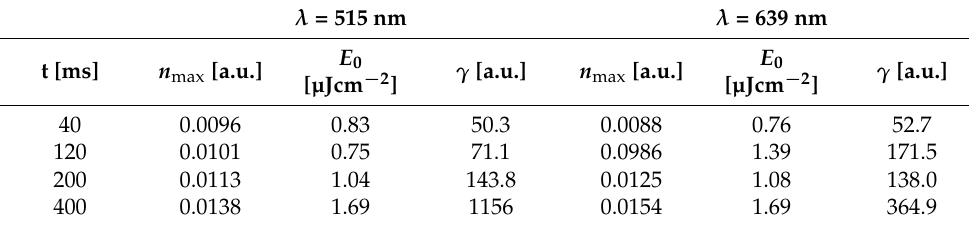
Figure 7. ( a ) Measured relative diffraction efficiencies of several holograms recorded at equal exposure energies; however, at different exposure times. A time dependence of the achievable diffraction efficiency can be observed. The inset outlines several power sweeps outlining, the saturation regime of the holograms at the evaluated energy level (red bar). ( b ) Outline of the vHOE’s bandwidth as FWHM for equal energy levels as displayed in ( a ). Table 1. Fit parameters, monochromatic